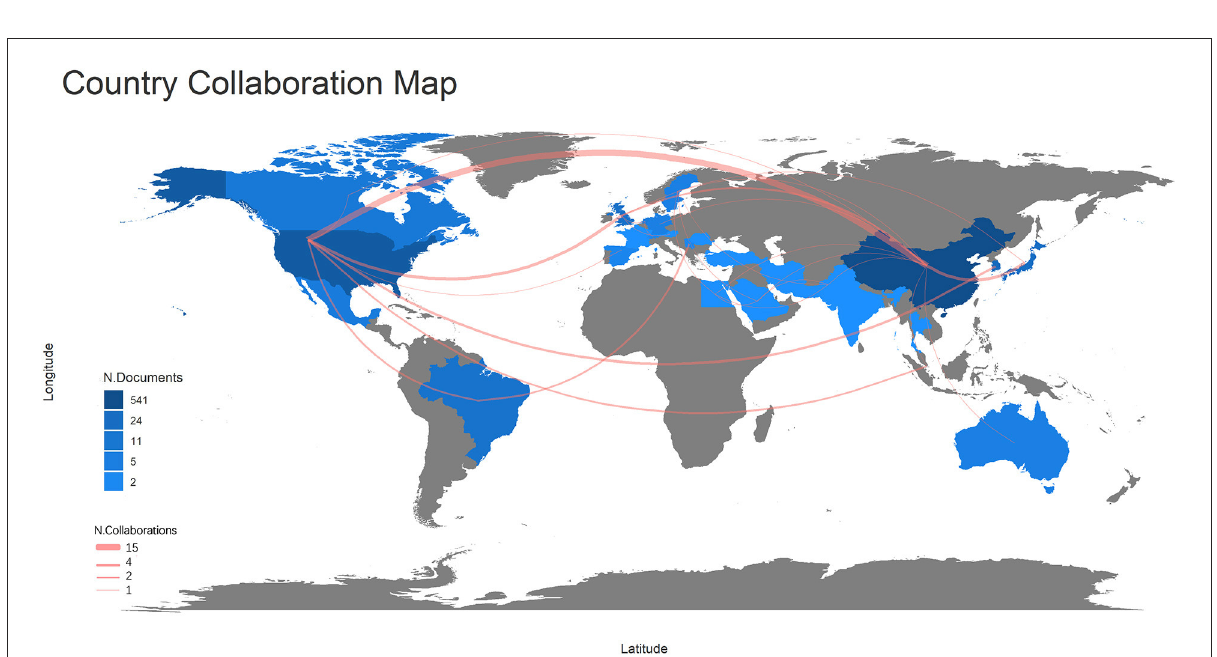
FIGURE3 Map of national collaborations for acupuncture for SCI publications (Gray, no relevant publications in the country; blue, related publications in the country; depth of blue, number of publications; red line, connected countries have cooperation in the field, the thickness of the line: frequency of